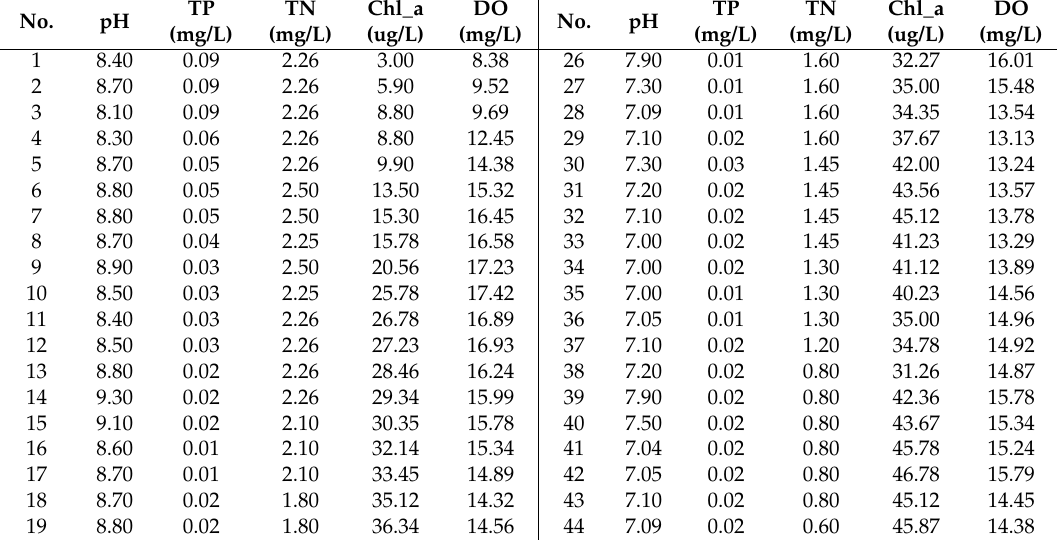
Table A1. Water quality data from sensors and the standardization